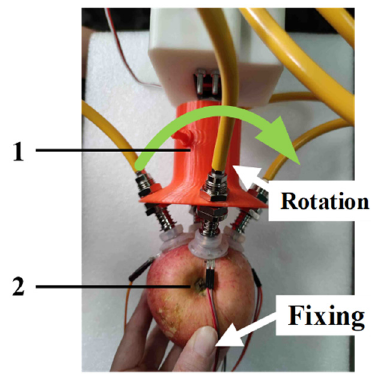
Figure 28. End-effector testing on different apple sizes.